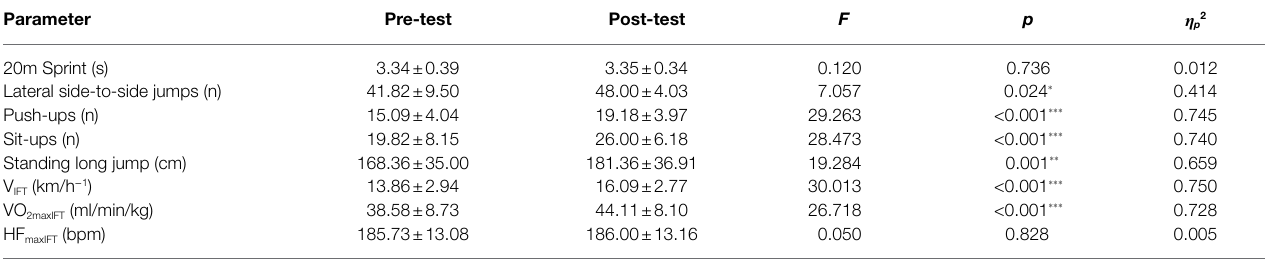
TABLE 3 | Motor performances (means ± SD) before and after the intervention ( n = 11). Parameter